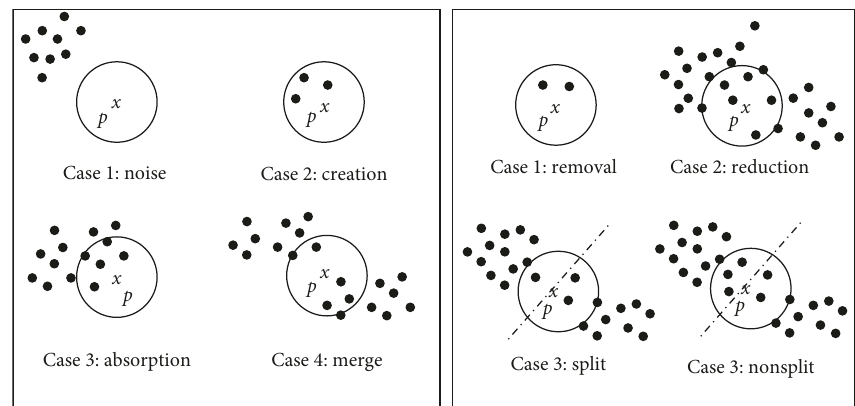
Figure 3: Insertion cases (a) and deletion cases (b) of IncrementalDBSCAN